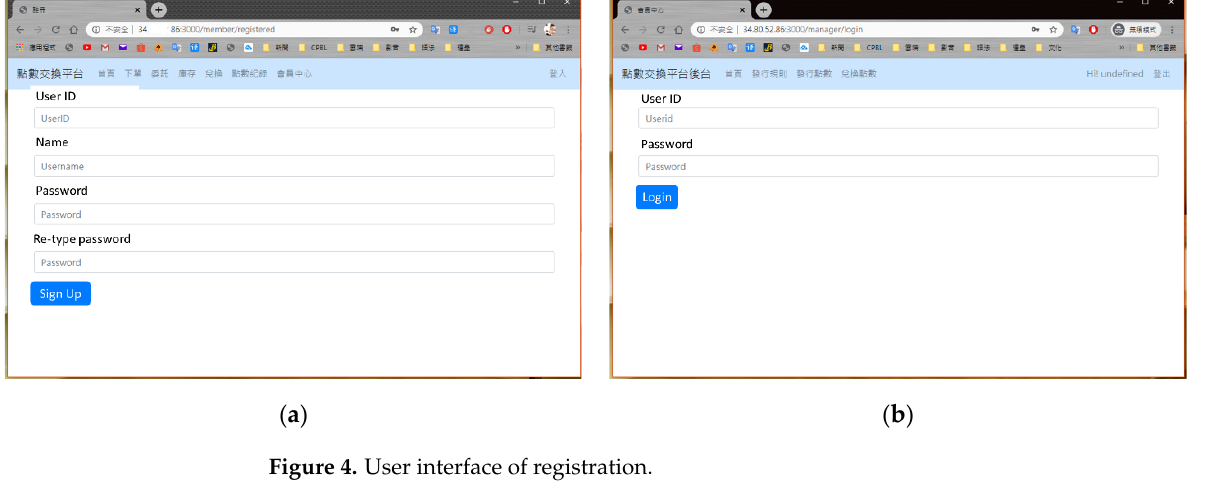
10 Figure 2. Interactions between users and the blockchain network.